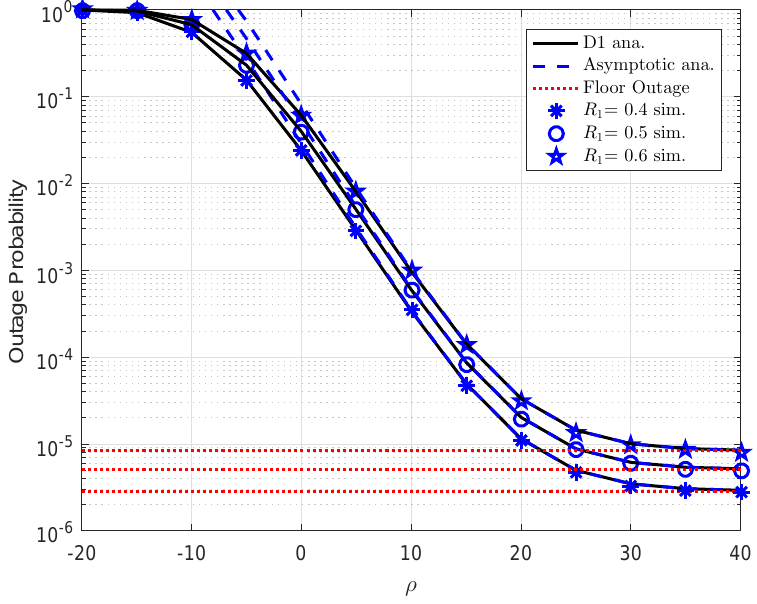
Figure 3. Outage performance of D 1 as varying R 1